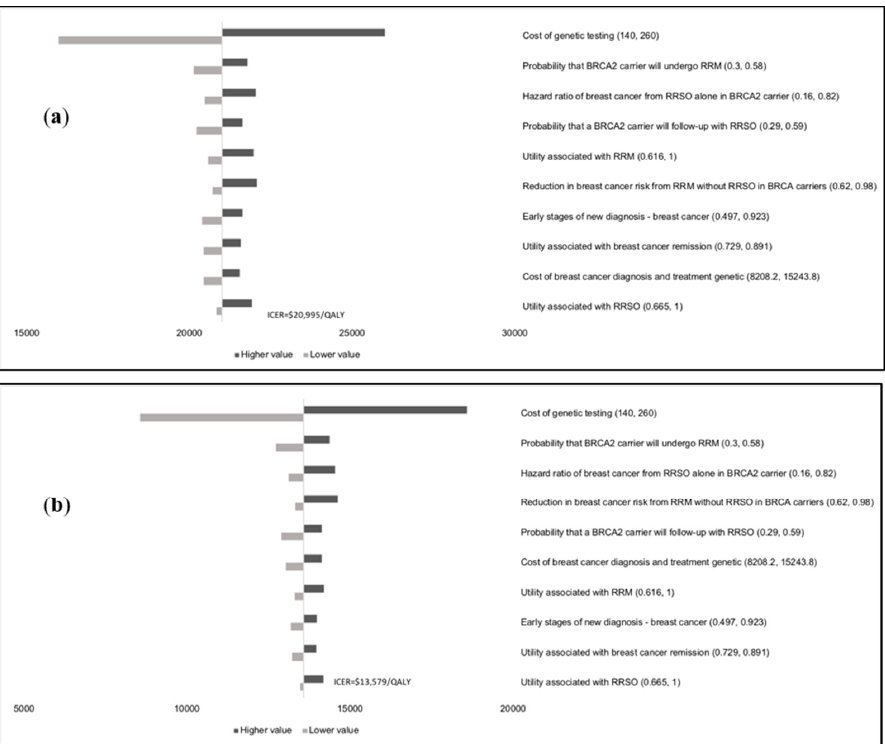
Figure A5. Tornado Diagram in Brazil ( a ) from the healthcare payer perspective. ( b ) from the societal perspective.